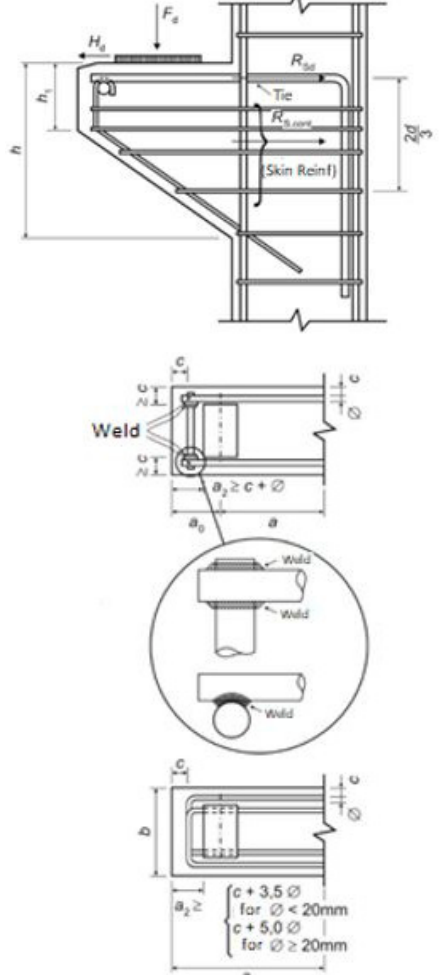
Figure 3. Typical reinforcement for corbels according to ABNT NBR6118 [11].